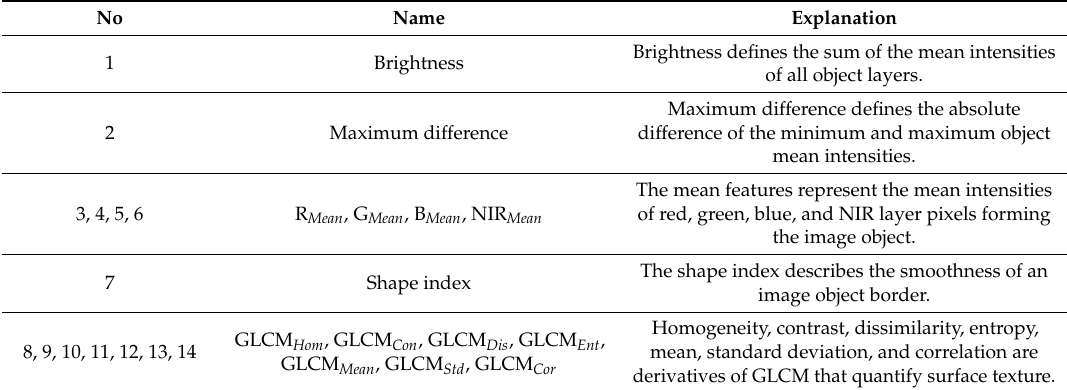
Table 5. Image object features used as classification